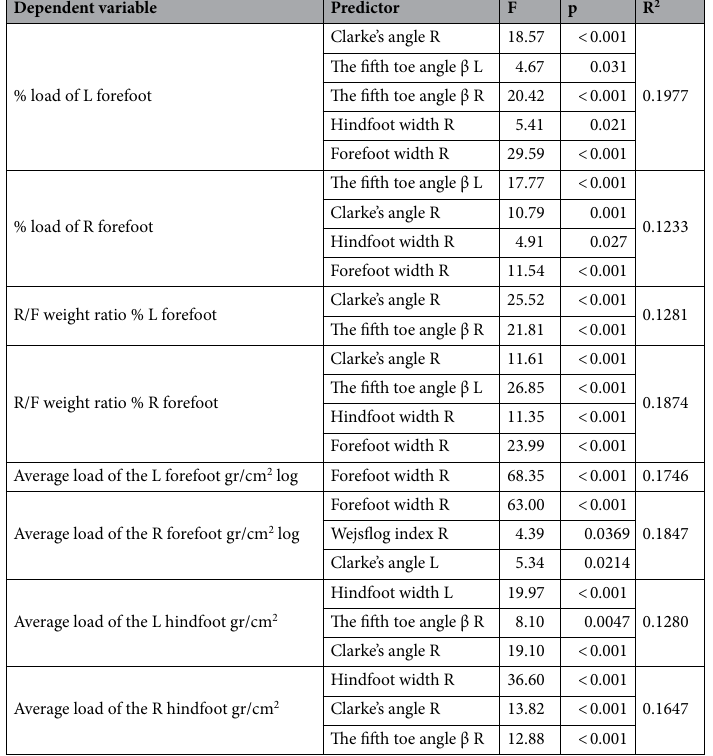
Table 6. Stepwise regression models in the group of